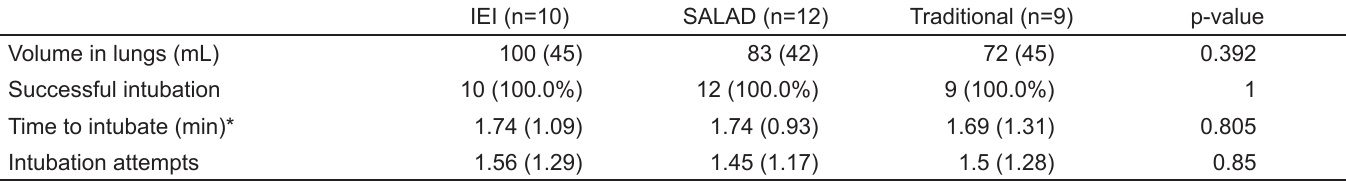
Table 2. Primary and Secondary Outcomes of Airway Management Technique.